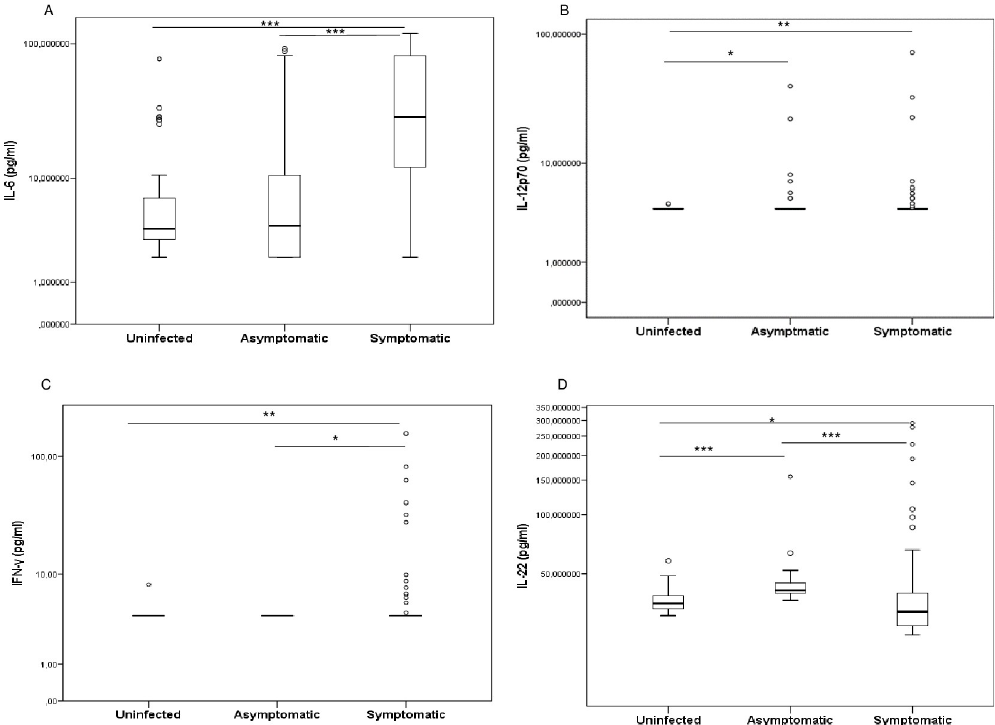
Fig 1. Levels of interleukin IL-6 (A), IL-12p70 (B), IFN- γ (C) and IL-22 (D) in plasma in children infected with P . falciparum and uninfected children. Concentrations were quantified using enzyme-linked immunosorbent assays (ELISA) and compared between uninfected, symptomatic and asymptomatic children in pairs. Cytokine concentrations were represented by boxplots with medians and interquartile range (IQR) in pg/ml on the log10 scale. Statistically significant differences between groups were tested using the Mann–Whitney method and are represented as � p < 0.05; �� p < 0.001; ��� p = 0.0001; ���� p < 0.0001.